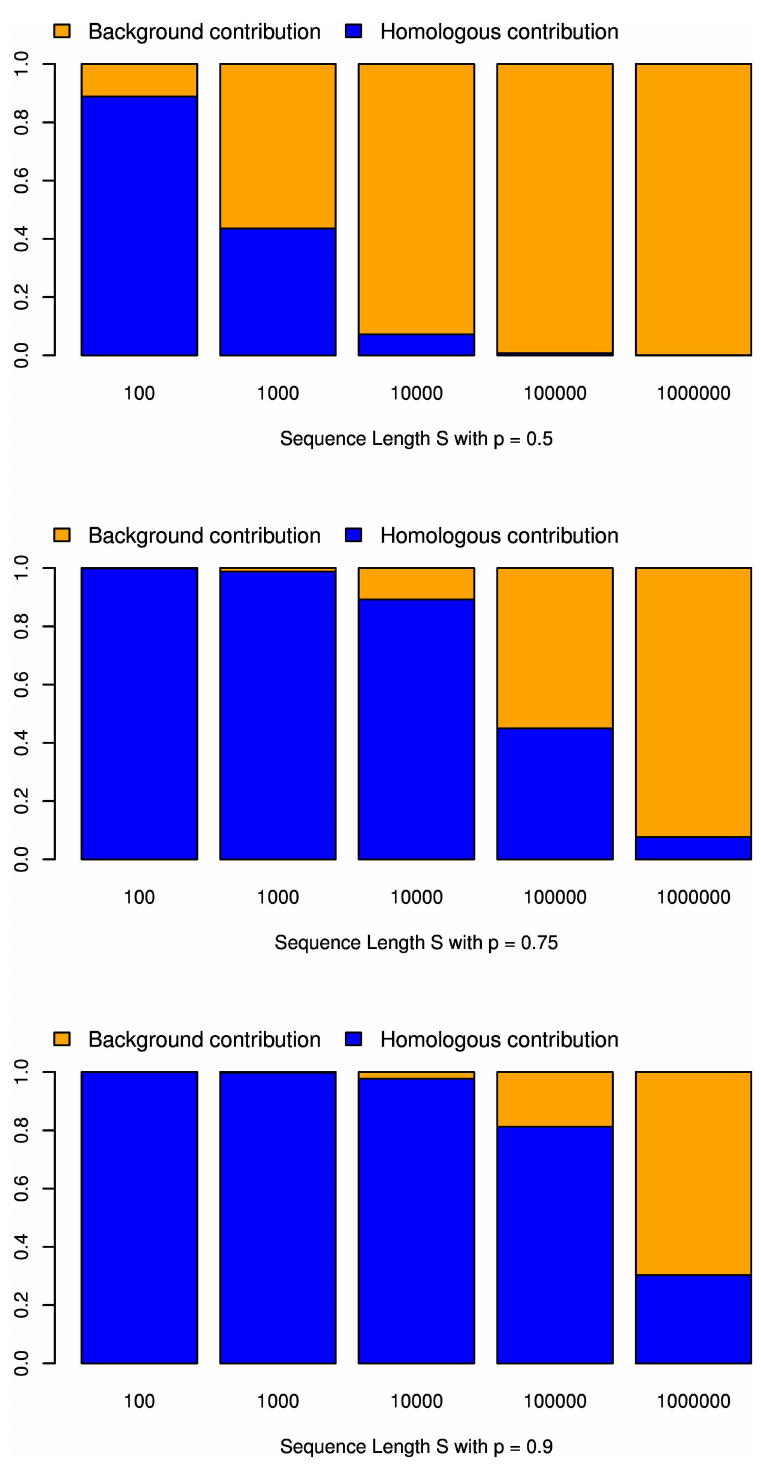
Fig 1. Homolgue and background contribution to the variance of the number N of spaced-word matches. Contribution of the homologue and background variance to the total variance of the number N of spaced-word matches in eq (4) for different match probabilities p and sequencelengths L .